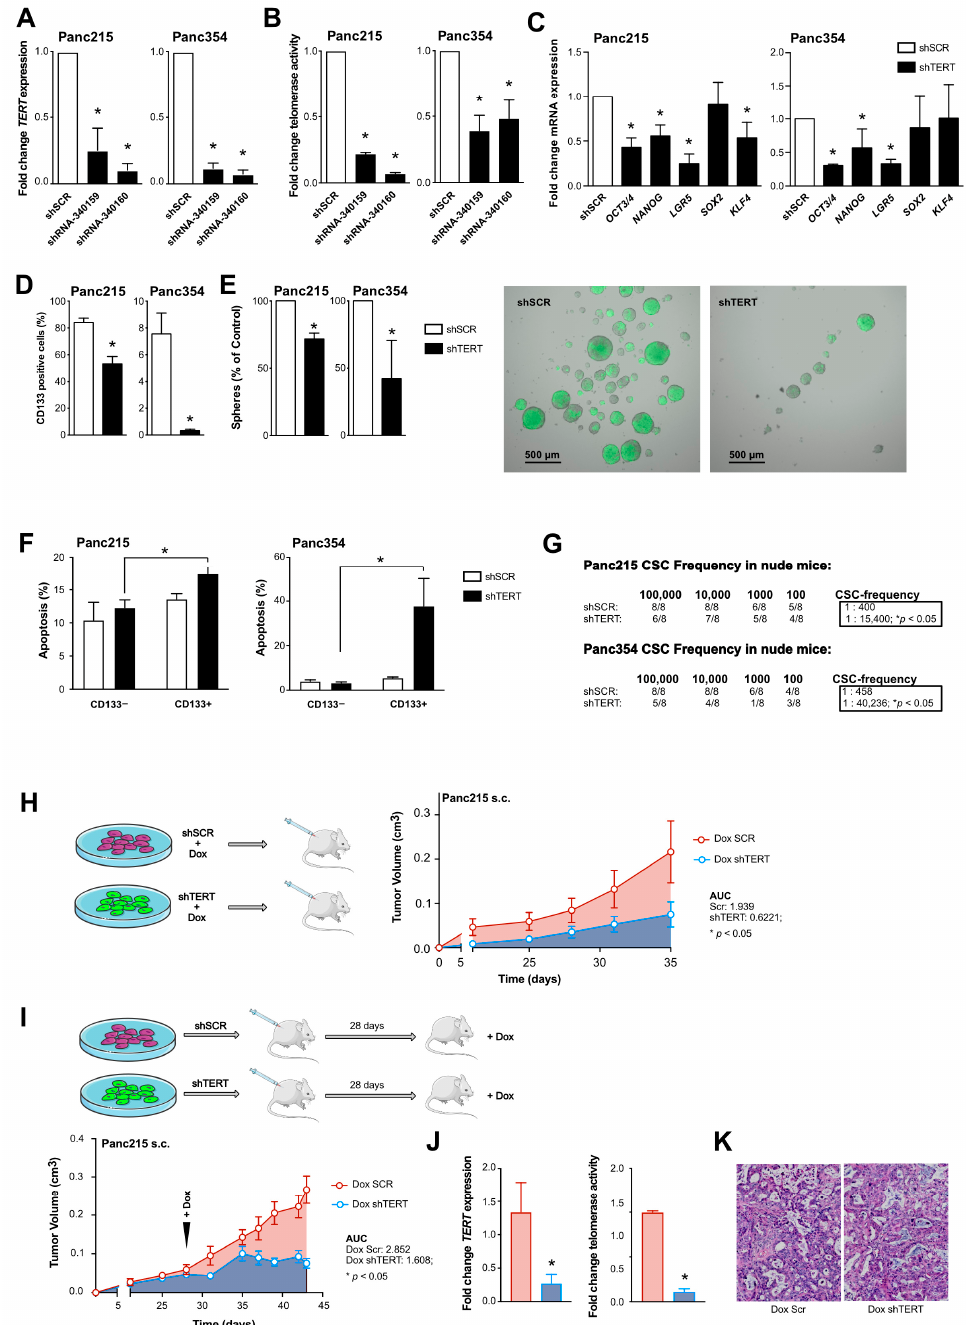
Figure 5. Knockdown of TERT diminishes pancreatic cancer stem cells: ( A , B ) Gene expression of TERT ( A ) and telomerase activity ( B ) in Panc215 and Panc354 cells transduced with shRNA-340159 and shRNA-340160 compared to scrambled (shSCR) control. ( C ) Expression levels of stemness/pluripotency-associated genes using shRNA-340160 (shTERT) for TERT mediated knockdown in Panc215 and Panc354 cells. ( D , E ) Flow cytometry analyses for CD133 ( D ) and sphere formation ( E ) upon TERT knock-down (KD) compared to scrambled (shSCR) control. ( F ) Quantification of apoptosis in shSCR and shTERT transduced cells (Panc215 and Panc354) using flow cytometry analysis for AnnexinV ( n = at least 3 independent experiments). ( G ) In vivo tumor-initiating potential with CSC frequencies (number of tumorigenic cells within the whole population) as determined by ELDA in nude mice after TERT-KD compared to scrambled control ( n = 8 animals); ( H ) Schematic illustration of in vivo experiment with cells carrying an inducible TERT-KD (Dox shTERT) or scrambled (Dox SCR) control construct. Cells were treated with doxycycline (DOX) 7 days before s.c. xenografting in nude mice. Graph shows time-dependent growth of subcutaneously engrafted tumors ( n = 4 mice per group). ( I )